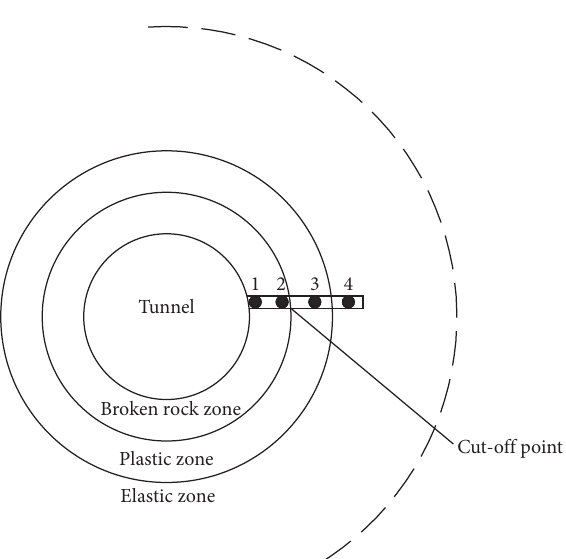
Figure 3: Test principle of multipoint displacement meter